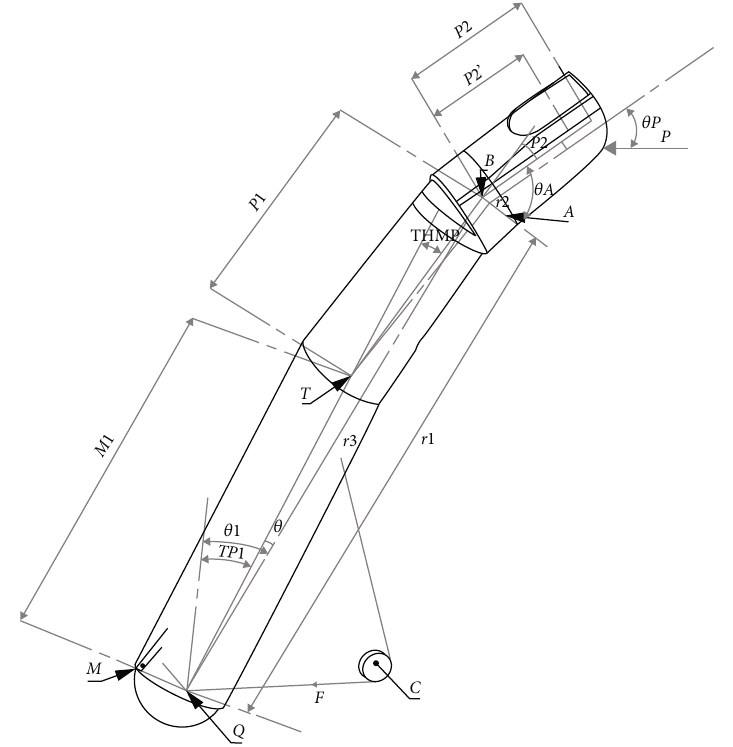
Figure 1: Schematic diagram of the thumb fi nger fi t out with its driving